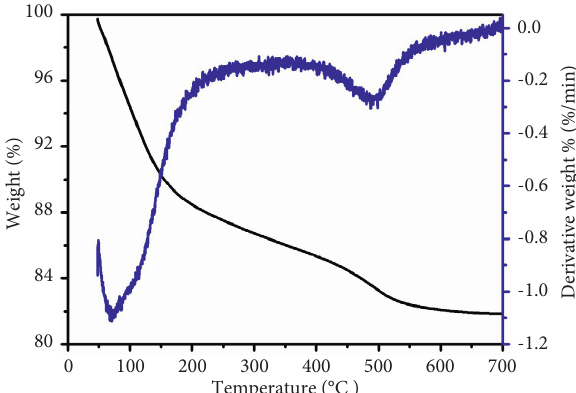
Figure 4: TGA curve and DTA curve of the GTNT